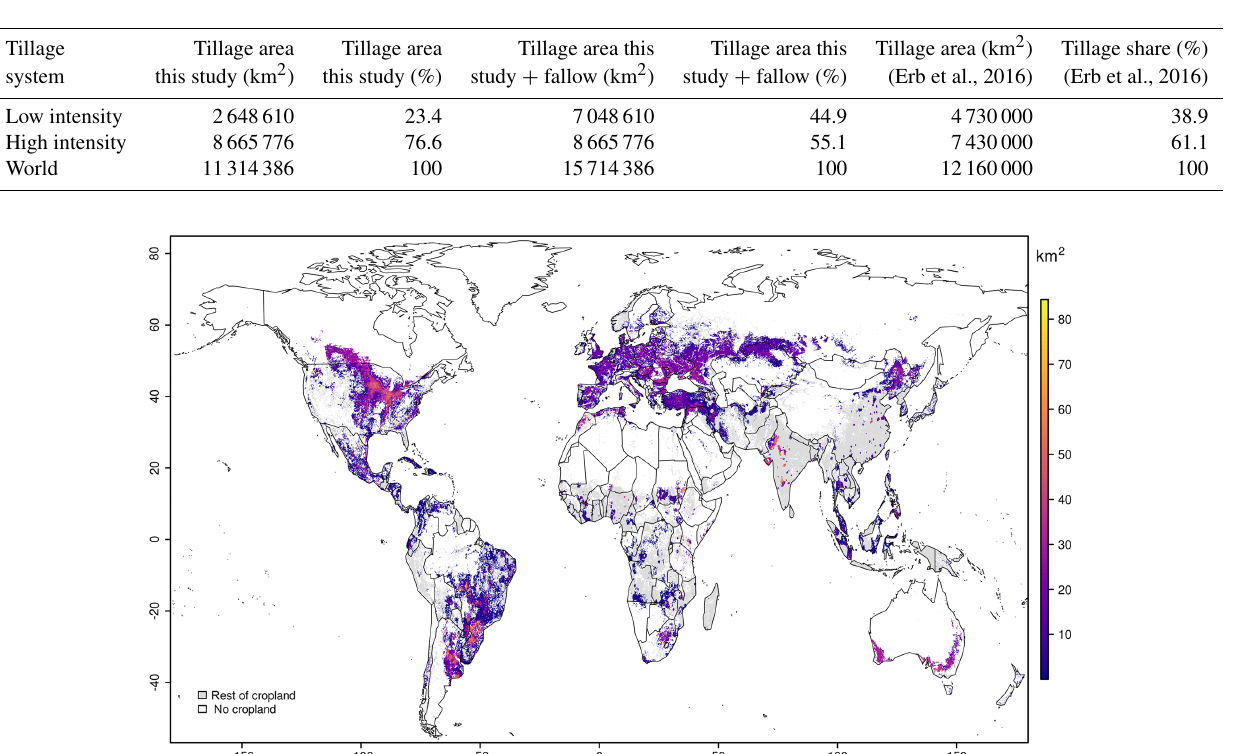
Table 7. Tillage system area results compared to estimates of Erb et al. (2016) on tillage intensity areas. The first two columns show our aggregated tillage system area values; columns 3 and 4 additionally include the young and temporal fallow cropland area by Siebert et al. (2010), a cropland area not represented in SPAM2005 and therefore added to our total cropland as well as to the “low intensity” category as described in Erb et al. (2016). Note that Siebert et al. (2010) state that about 4.4Mkm 2 of cropland was young and temporal fallow ( < 5 years) around the year 2000.